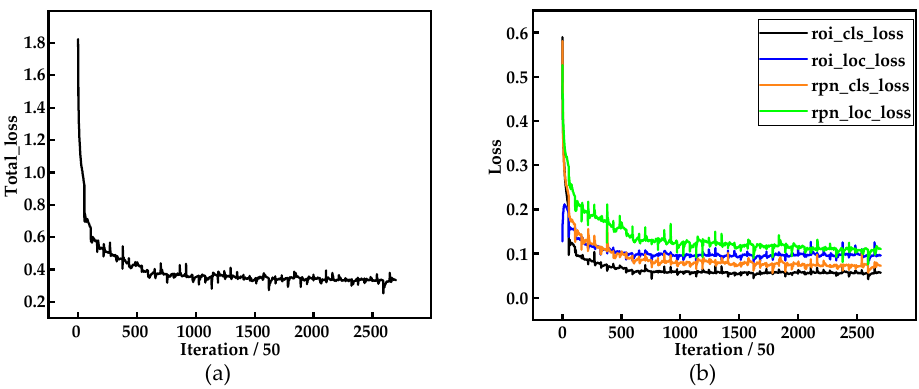
Figure 10. ( a ) The total_loss curve during the process of network training; and ( b ) the roi_cls_loss, roi_loc_loss, rpn_cls_loss, and rpn_loc_loss curves during the training.